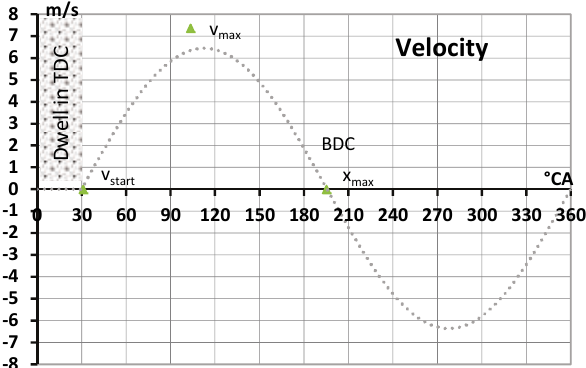
Fig. 5. Characteristic points of velocity (green points) against the back- ground of the base function (gray line)